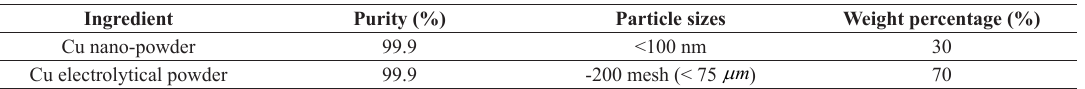
Table 1. Purity level, particle size and weight composition of precursor powder materials.